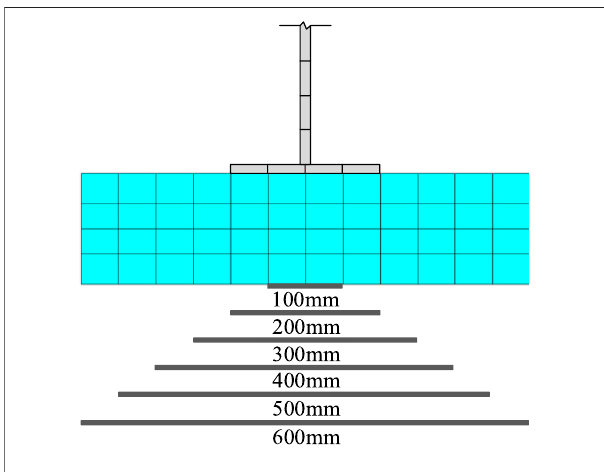
FIGURE 11 | Arrangement of the CFRP with different